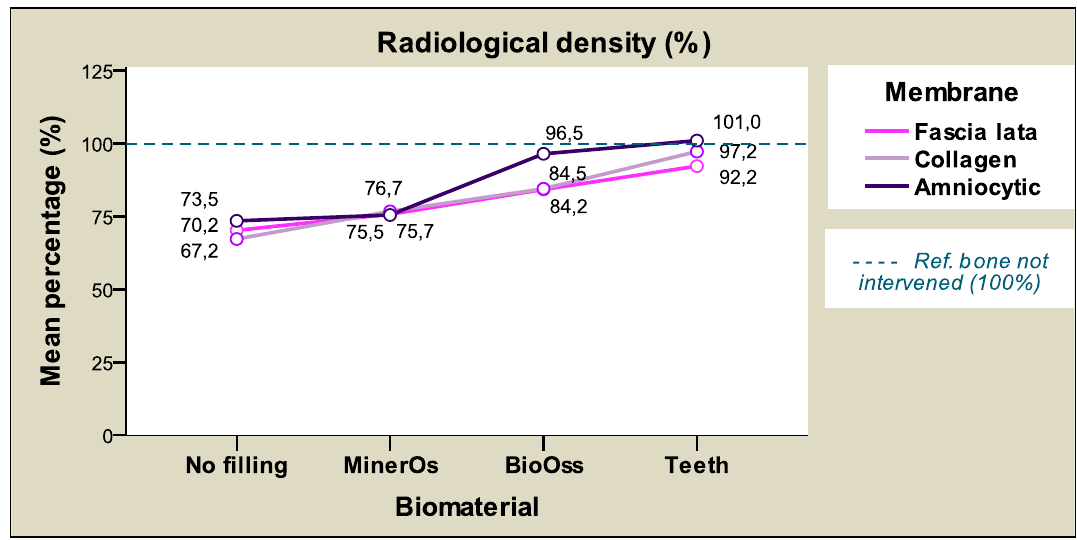
Figure 10 . The radiological density percentages (average) according to the membrane and filling material. Histological